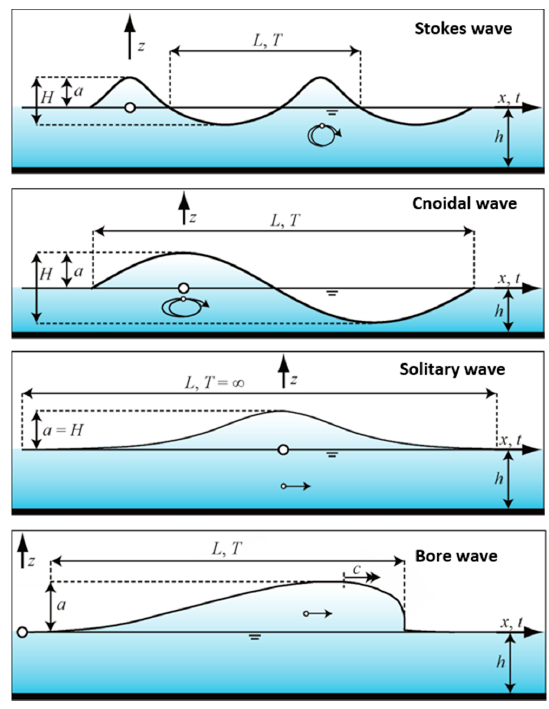
Figure 9. Idealized impulse wave types with the most important wave parameters (from Heller et al. [2], with permission from ETH, 2019).